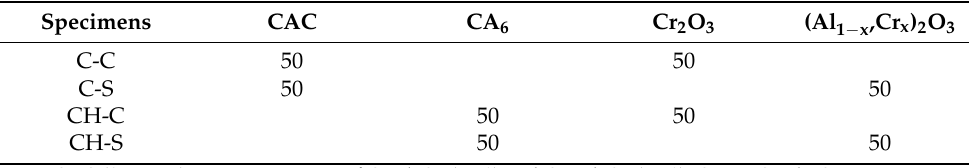
Table 3. The formulation of cylindrical specimens